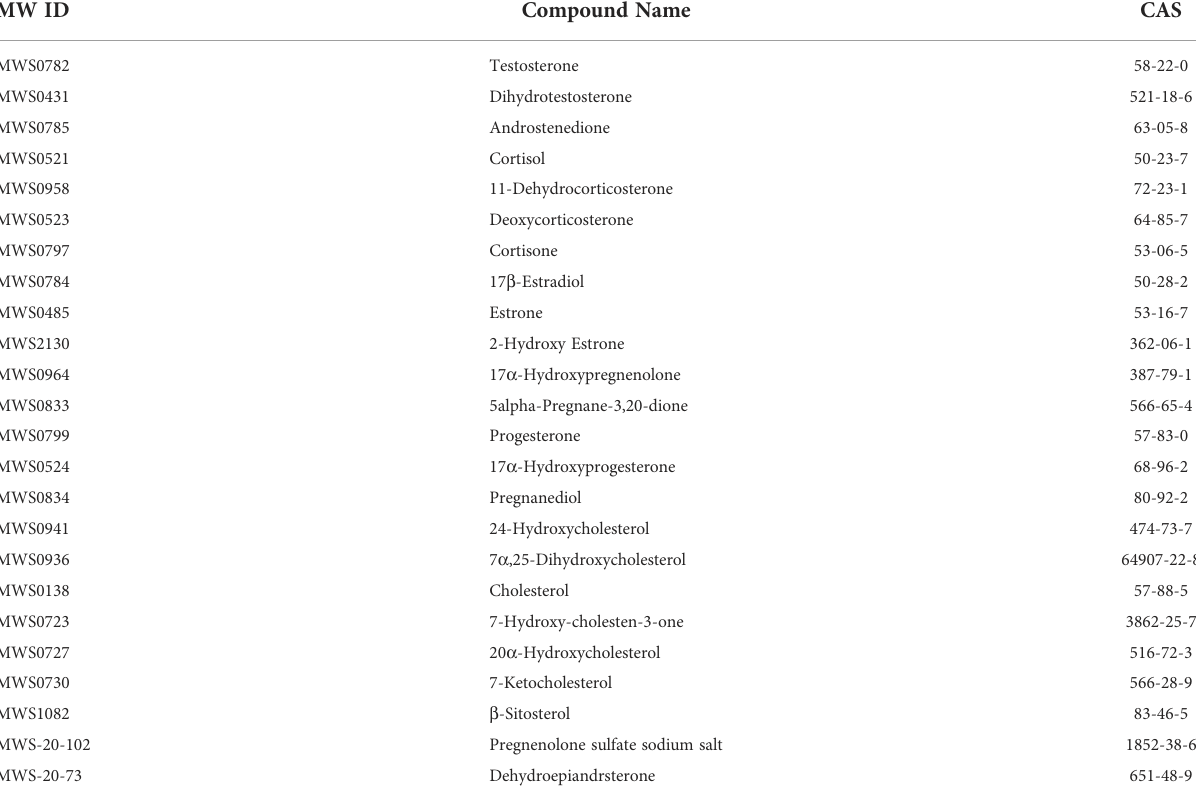
TABLE 2 Key resources for steroids metabolism